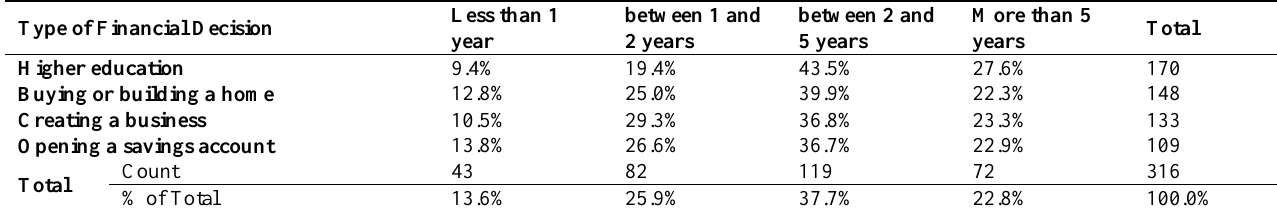
Table 3: Type and time gap since financial decision was taken